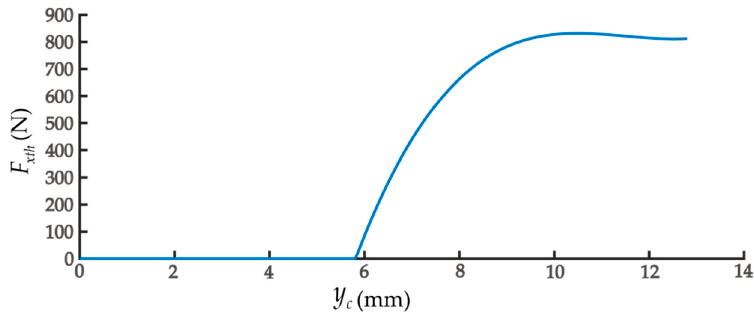
Figure 3. Relationship between spring pressure and release bearing position.